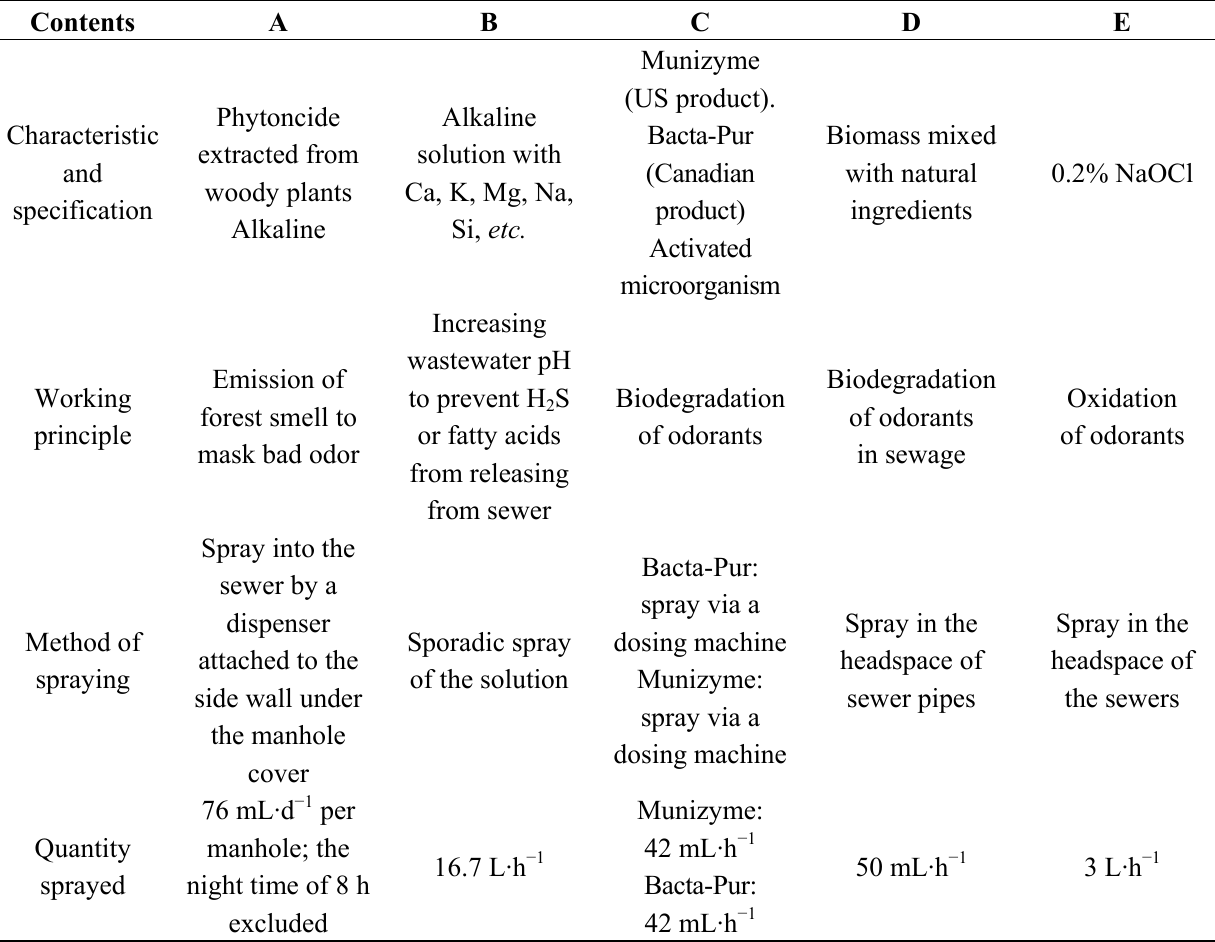
Table 1. Characteristics of odor reducing agent used in